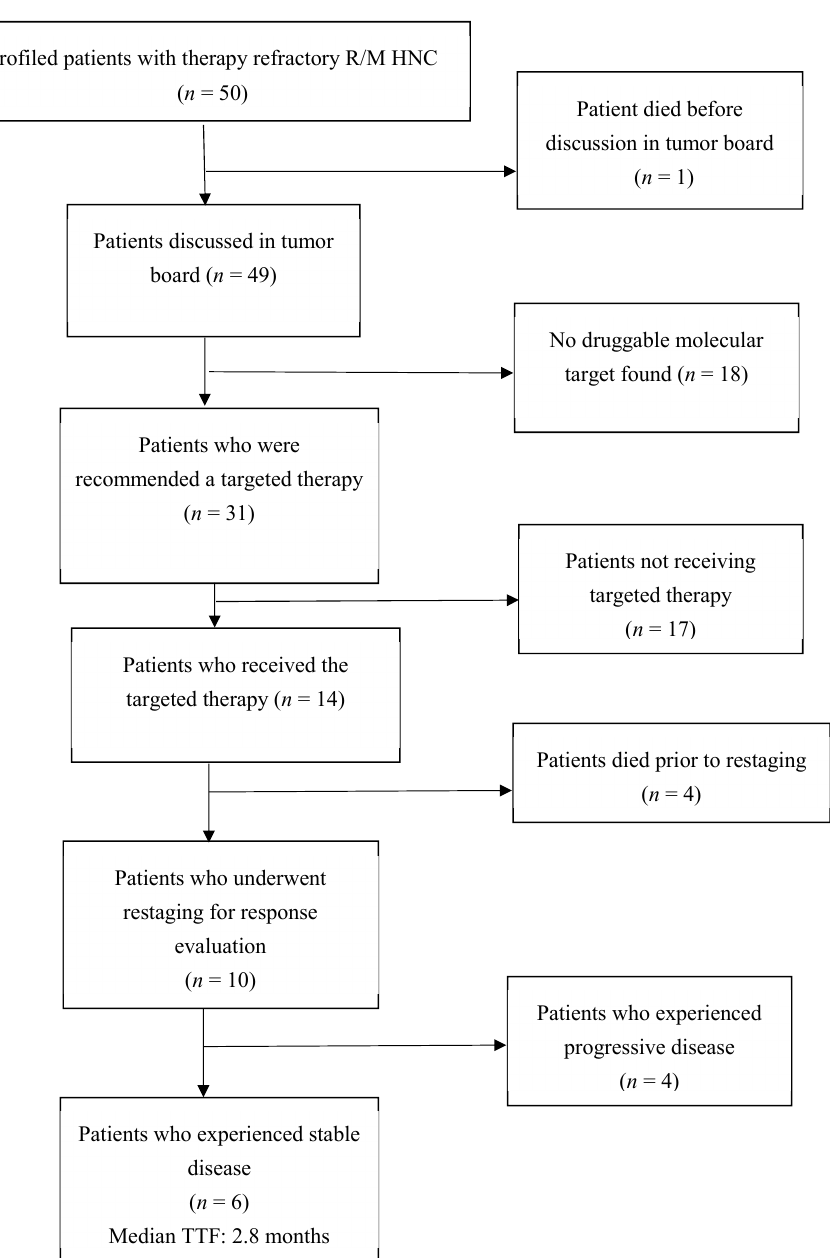
Figure 3. Flow chart of the 50 R/M HNC patients.